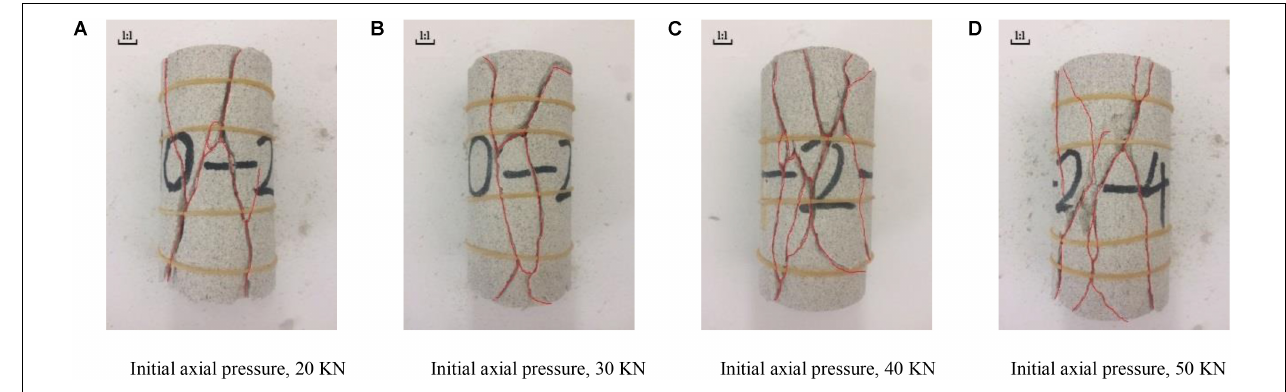
FIGURE 7 | Failure patterns of white sandstone samples subjected to the loading and unloading of triaxial confining pressure followed by uniaxial compression. (A) Initial axial pressure, 20 kN; (B) Initial axial pressure, 30 kN; (C) Initial axial pressure, 40 kN; (D) Initial axial pressure, 50 kN.